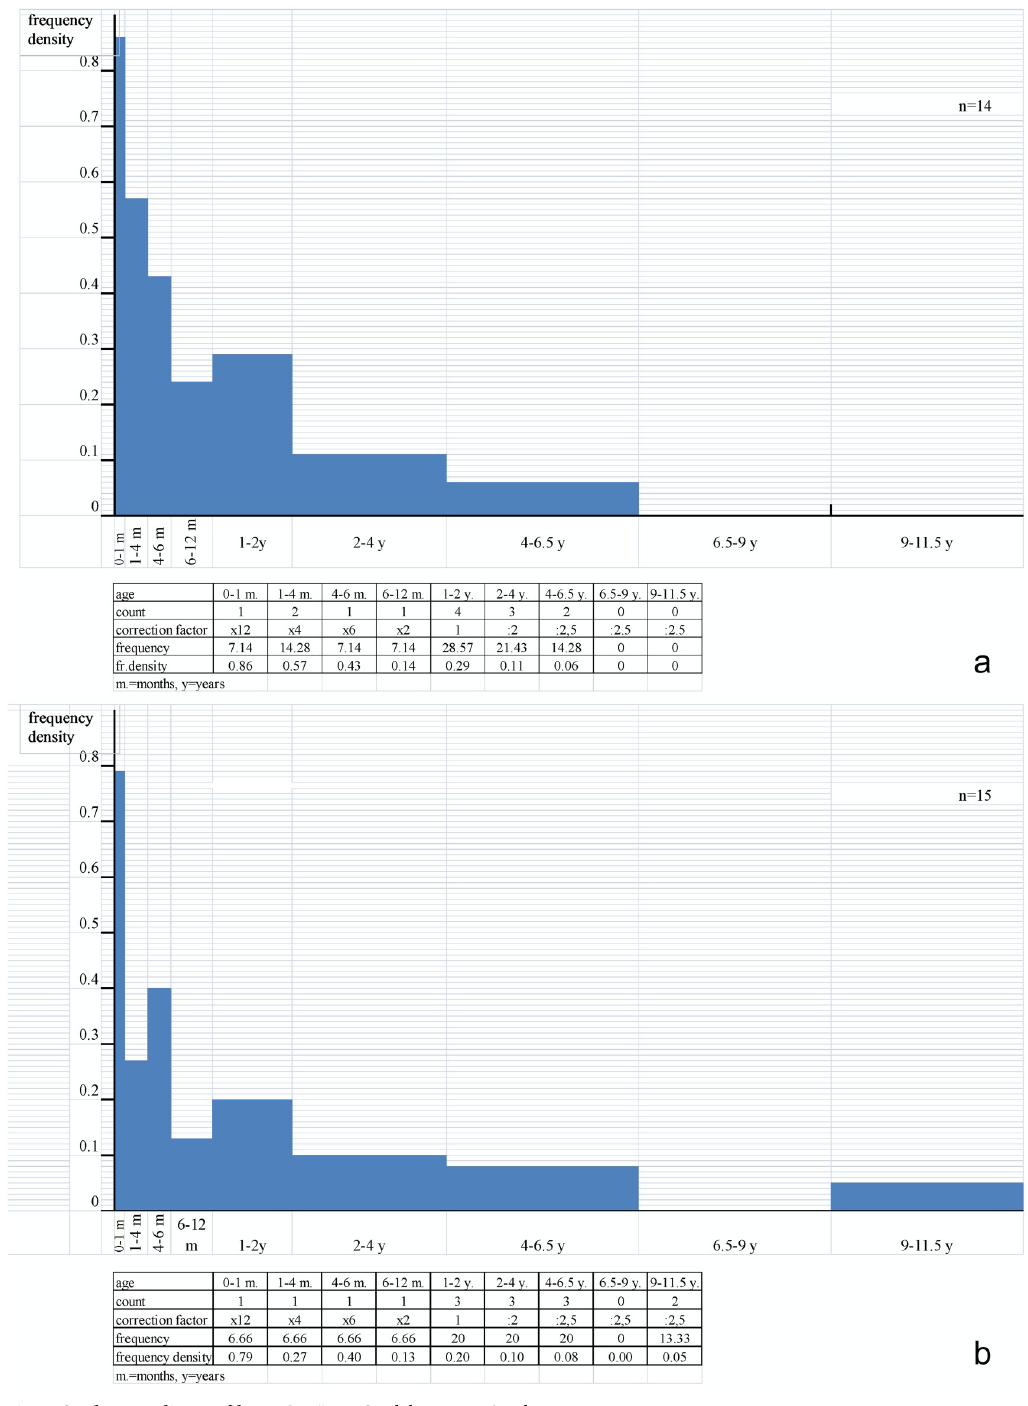
Fig 5. Cattle mortality profiles. a. Star č evo-Grad, b. Magare ć i Mlin.